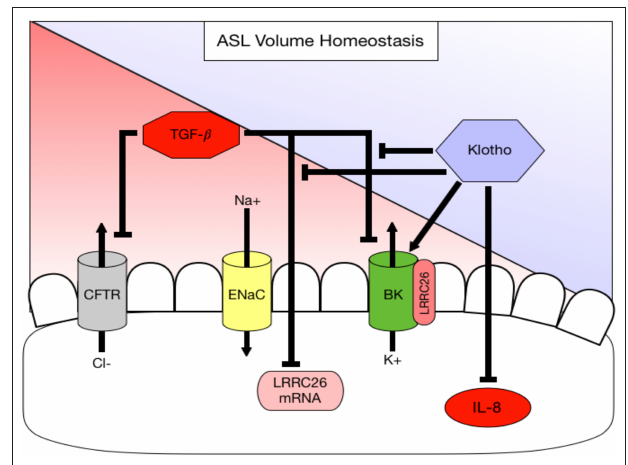
FIGURE 4 | Diagram summarizing working hypothesis. Klotho exerts an activating effect on the apical BK channel through a direct action but also indirectly by attenuating (1) a TGF- β -mediated decrease in LRRC26, the regulatory subunit of the BK channel and (2) a TGF- β -mediated inhibition of BK. In addition, klotho decreases basolateral IL-8 secretion, which is pro-inflammatory thereby contributing to ASL volume dysregulation.